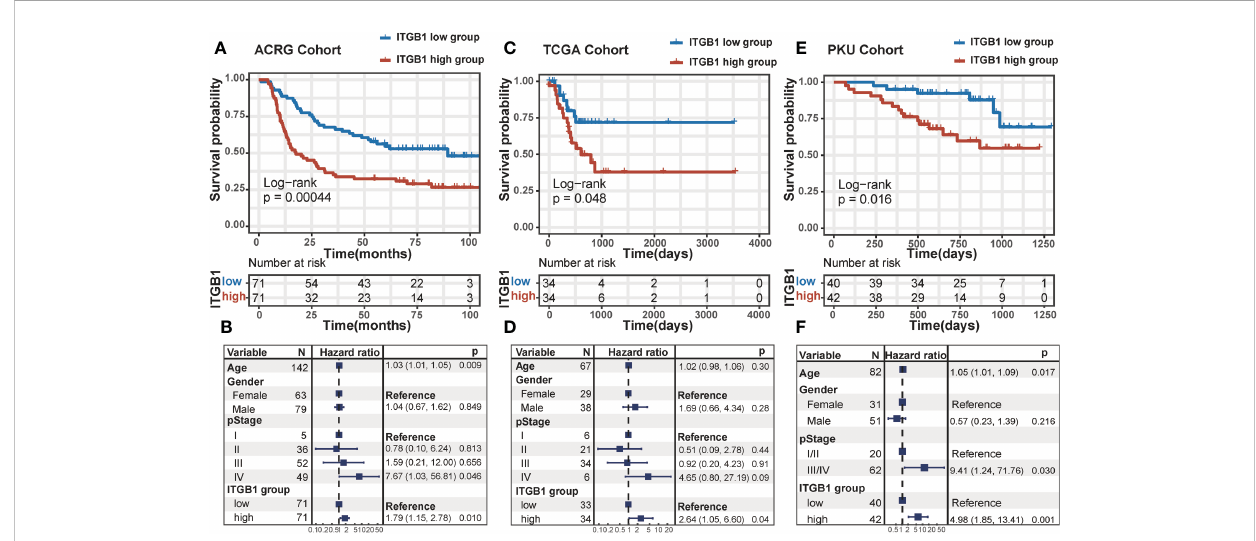
FIGURE 1 The survival analysis of ITGB1 in human DGC Kaplan-Meier curves of relapse-free survival according to ITGB1 high and low groups in the ACRG diffuse- type GC cohort (A) TCGA diffuse-type GC cohort (C) and PKU diffuse-type GC cohort (E) . Forest plot representation of the Multivariate Cox regression model delineated the association between ITGB1 and survival in the three cohorts (B, D, F) . Age, gender or stage were taken into